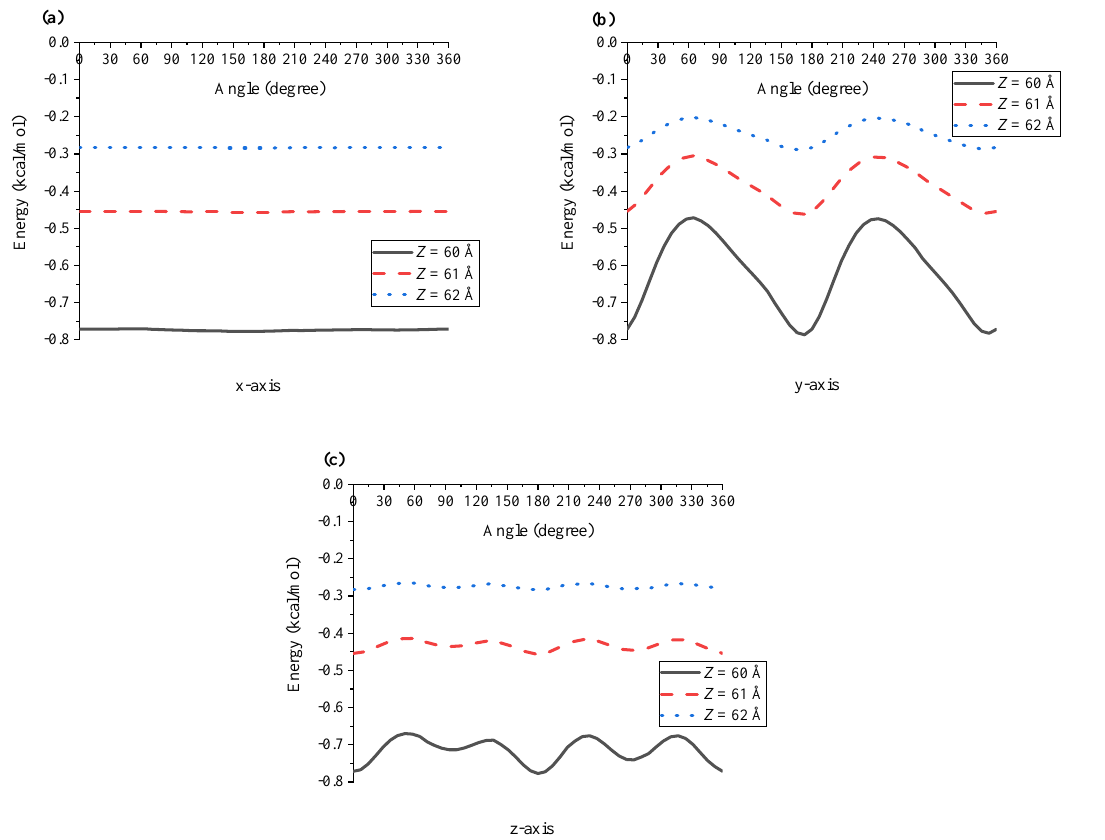
Figure 5. Interaction energy between dye molecule and TiO 2 when dye molecule rotates about ( a ) x -axis, ( b ) y -axis, and ( c ) z -axis.